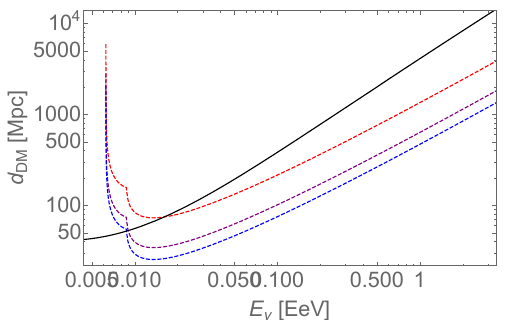
Figure 4. The viable region for τ -neutrino portal interaction. Figure 5. Same as Fig. 4 except for ˜ y τ = 1. The mean free path of the heaviest neutrino with E ν = 1EeV is M ψ = given in the right-hand side. We have taken M R τ > m φ τ (cid:31) 15 MeV and ˜ y τ = 4 π . The colored region might be excluded.